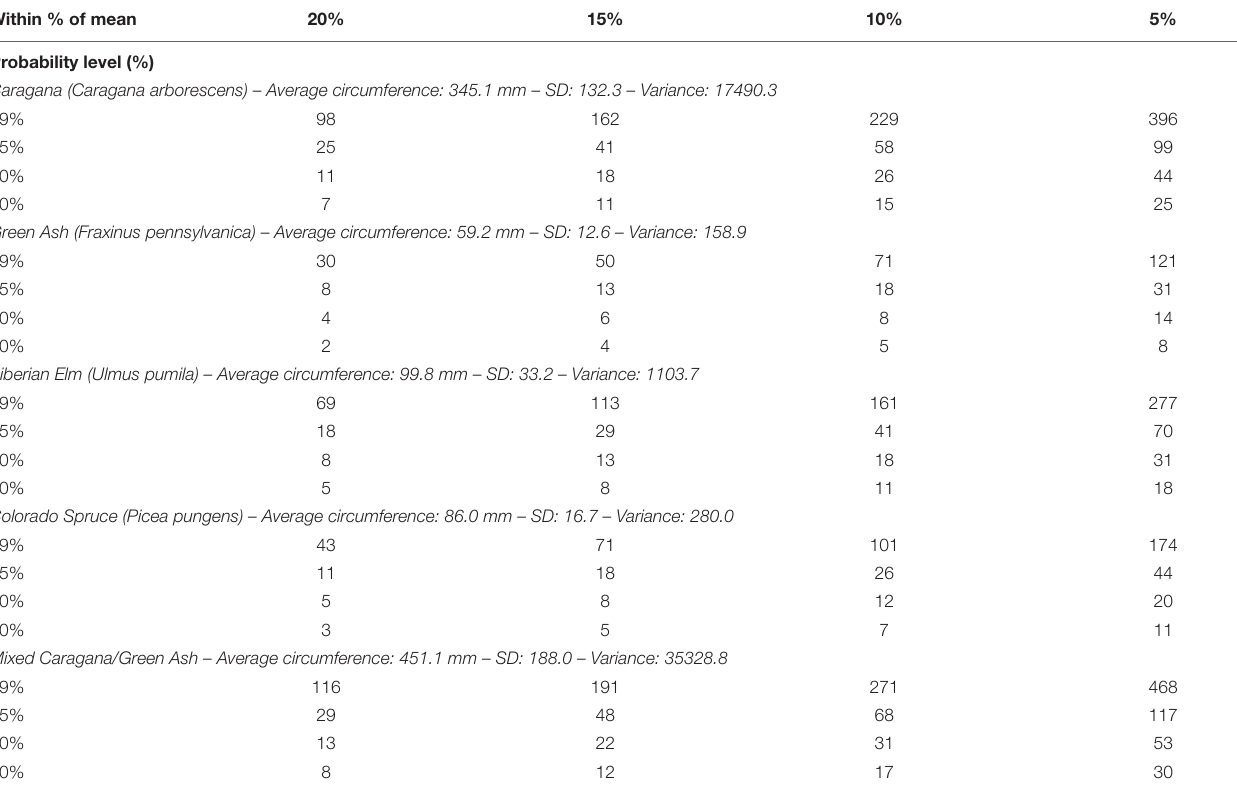
TABLE 4 | t -Test determined required number of samples for a representative estimation of average circumference for different shelterbelt species, based on measured shelterbelts from near Indian Head, SK, Canada. Within % of mean 20%